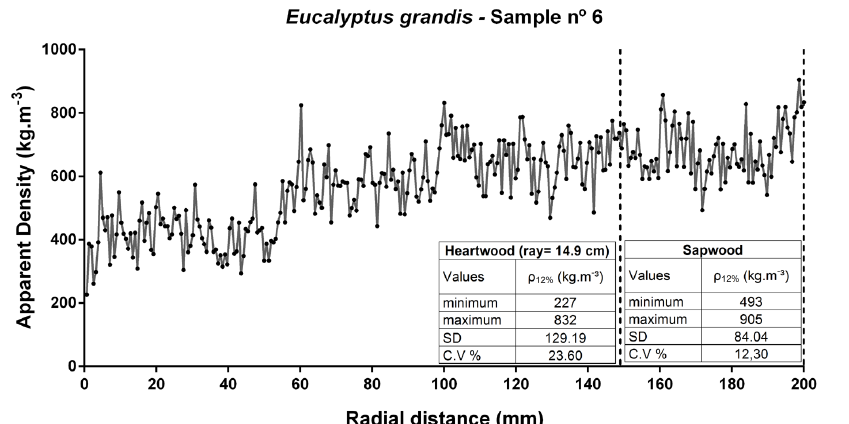
Figure 4 - Densitometry profile (apparent density) of Eucalyptus grandis - tree no 6, determined by the attenuation gamma radiation